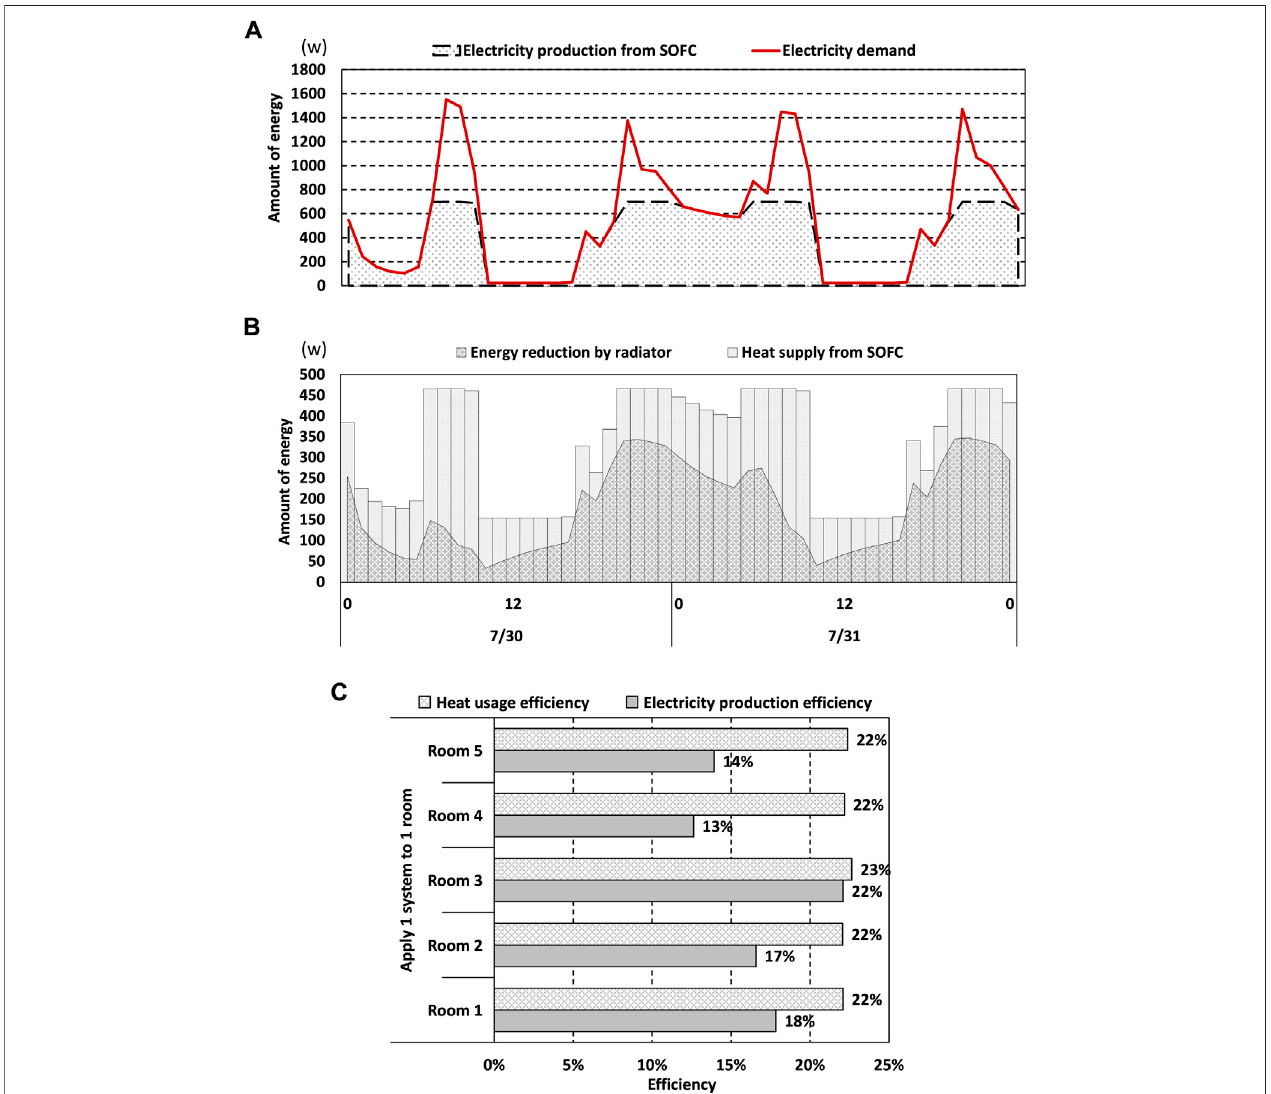
FIGURE 6 | Energy performance of using one SOFC – CGS in each room: (A) electricity production and demand of SOFC – CGS simulation for Room 3, (B) heat dissipation and usage of SOFC – CGS simulation for Room 3, and (C) annual electricity production and heat usage ef fi ciency of one SOFC – CGS/room.